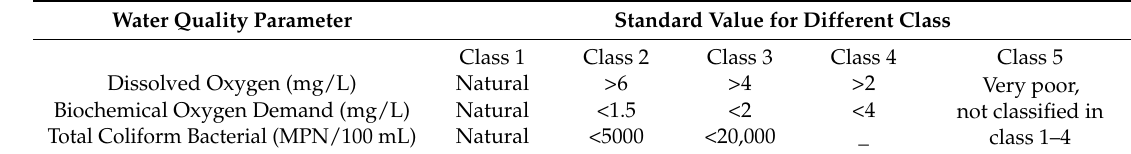
Table 1. Water quality standard of